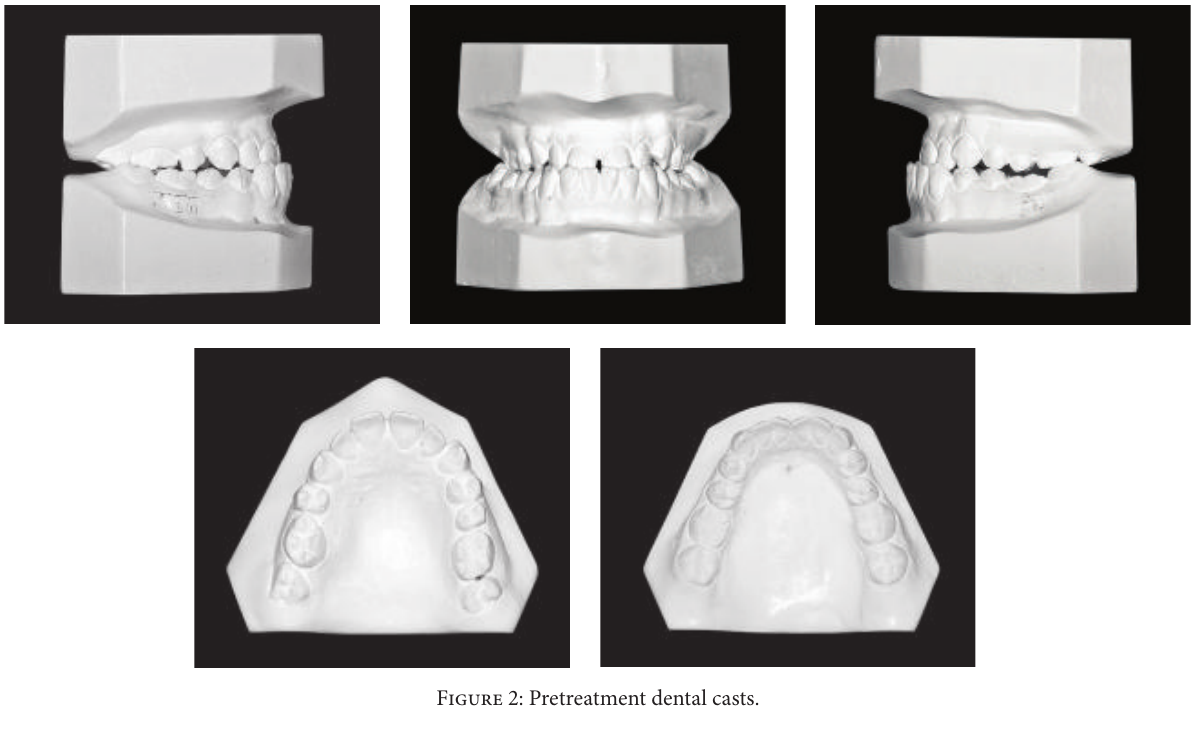
Figure 2: Pretreatment dental casts.